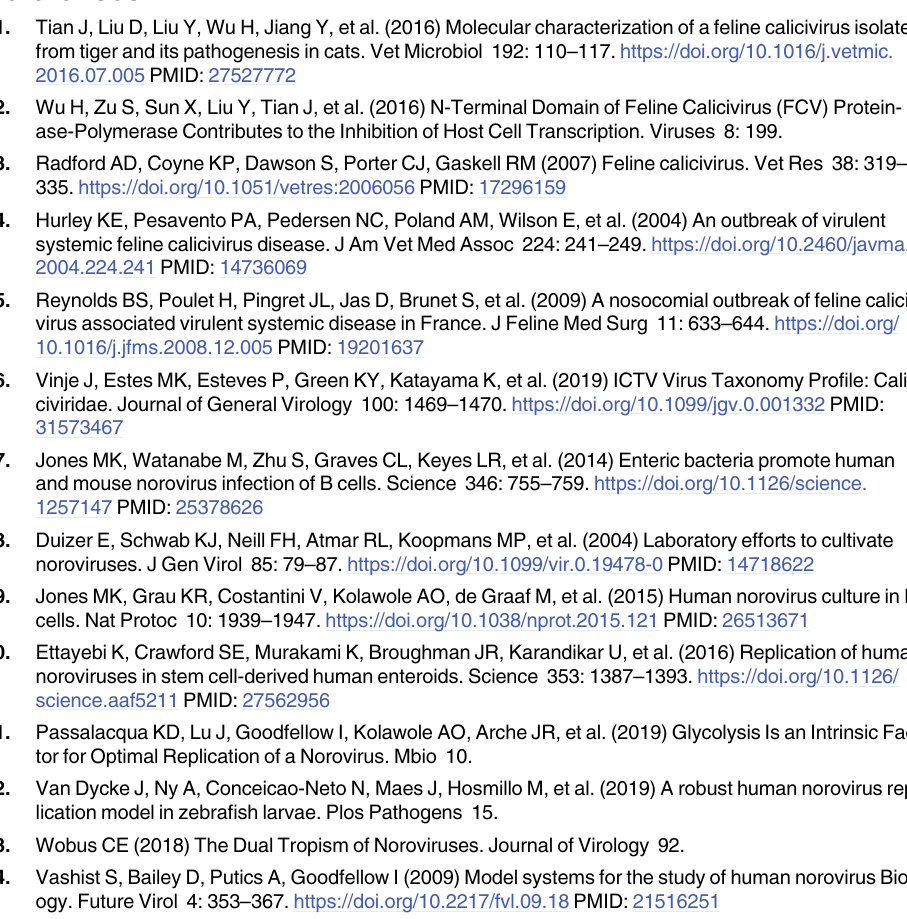
S4 Fig. Histology of the lung in the mock-infected and virus-infected cats. (TIF) S5 Fig. Alignment of the sequences and the predicted RNA secondary structures from the 5’UTR of IFNAR1/2. (TIF) S1 Table. Downregulated genes upon FCV 2280